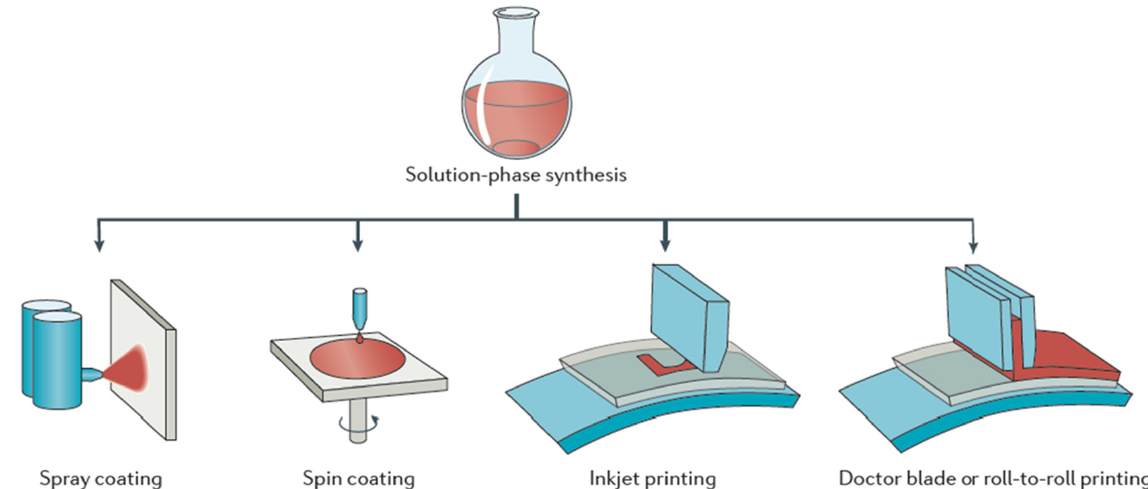
Figure 1. Different film preparation methods for solutions in the form of colloidal semiconductor inks. Reproduced from [3]. Reprinted with permission from ref. [3]. Copyright 2017 Nature Reviews Materials.